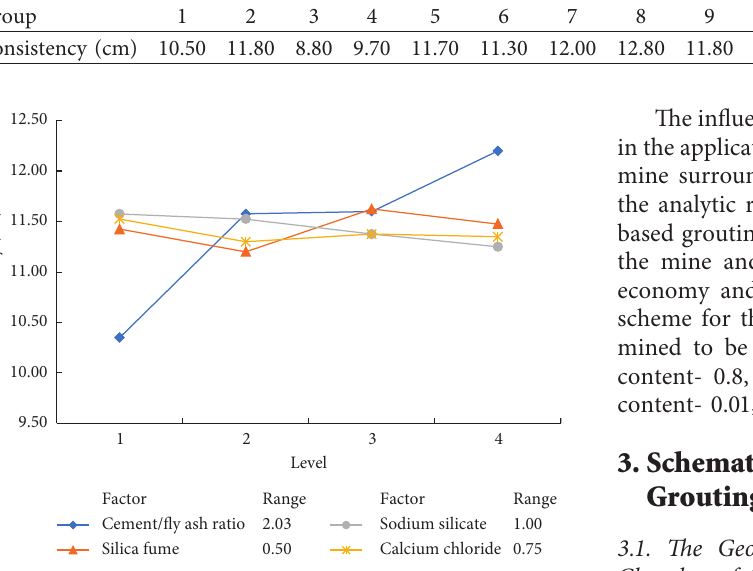
Figure 2: The analysis of the consistency of fly ash-based grouting materials in the slurry state.